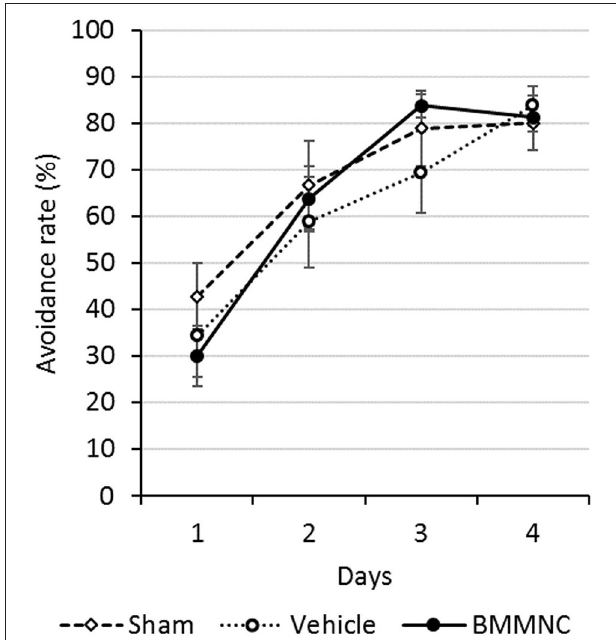
FIGURE 8 | Active avoidance test. The active avoidance test was serially performed on P35–38. The avoidance rates increased with time in all groups. There were no significant differences among all three groups on any day (Dunnett’s test). Open squares and dashed line: sham, n = 9; open circles and dotted line: vehicle, n = 8; closed circles and solid line: BMMNC, n = 8. Data represent the mean ± standard error of the